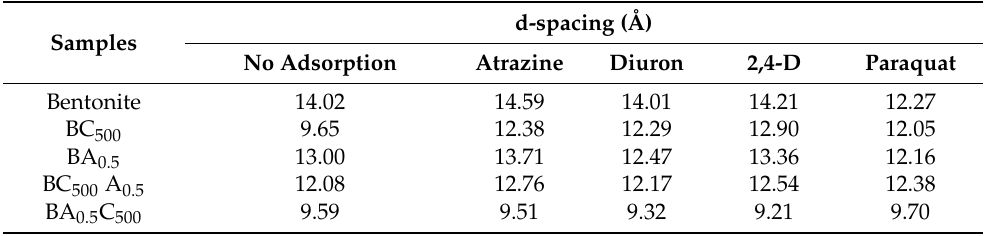
Figure 1. XRD patterns for bentonite (B), BC 500 , BC 500 A 0.5 , BA 0.5 , and BA 0.5 C 500 adsorbents. (Q = quartz; M = montmorillonite; C = cristobalite.). Table 2. The d-spacing (Å) of bentonite and modified bentonite changes upon atrazine, diuron, 2,4-D, and paraquat